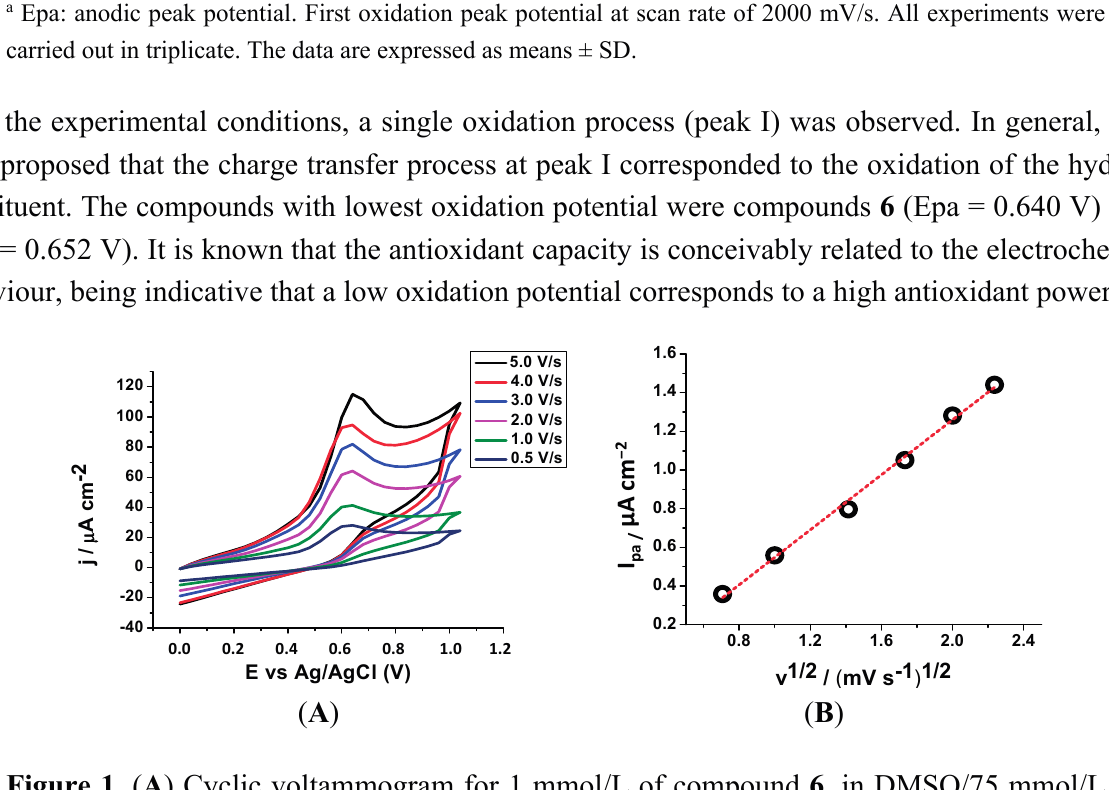
Figure 1. ( A ) Cyclic voltammogram for 1 mmol/L of compound 6 , in DMSO/75 mmol/L phosphate (pH 7.4) buffer 40/60 media at a GCE, for v = 0.5–5 mV/s. ( B ) Graphic of the anodic peak current versus the root of the scanning